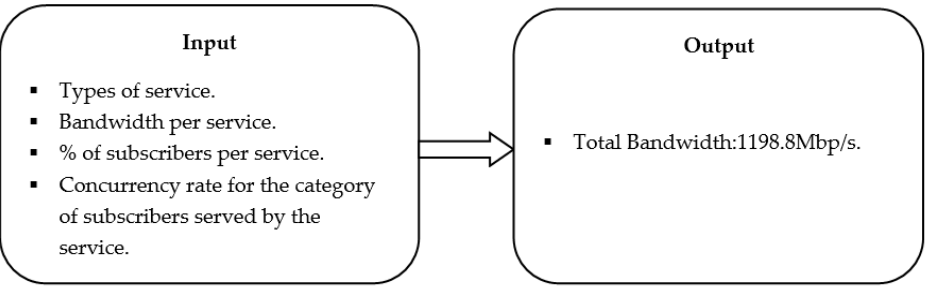
Figure 5. Input–output of the MATLAB calculator interface for calculating the total bandwidth per cell.